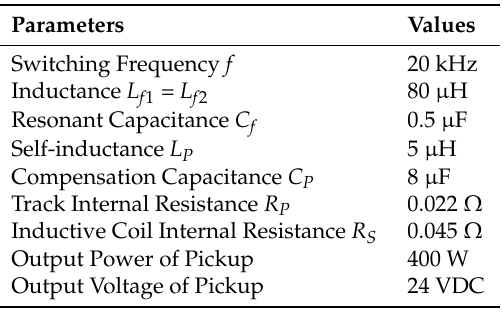
Table 1. Experimental parameters of IPT